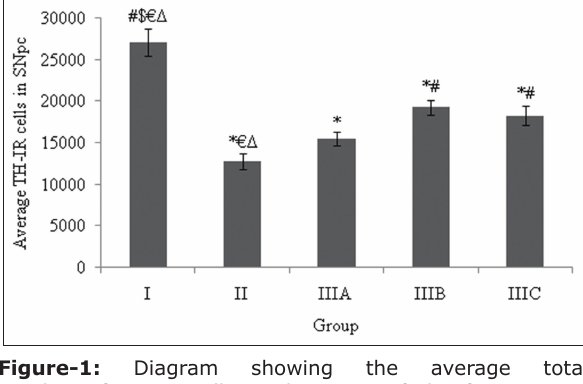
Figure-1: Diagram showing the average total number of TH-IR cells in the SNpc of the five groups. The symbol * indicates a significant difference compared with Group I; # indicates a significant difference compared with Group II; $ indicates a significant difference compared with Group IIIA; € indicates a significant difference compared with Group IIIB; Δ indicates a significant difference compared with Group IIIC total numbers of TH-IR cells in the SNpc of a PD rat